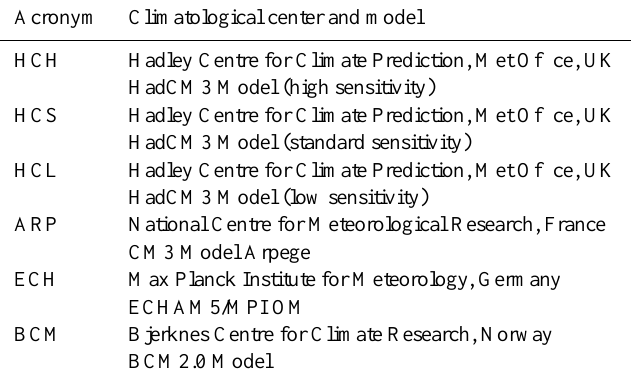
Table 2. Acronyms of the Global Climate Models (GCMs) used as drivers of ENSEMBLES Regional Climate Models (RCMs) considered in this